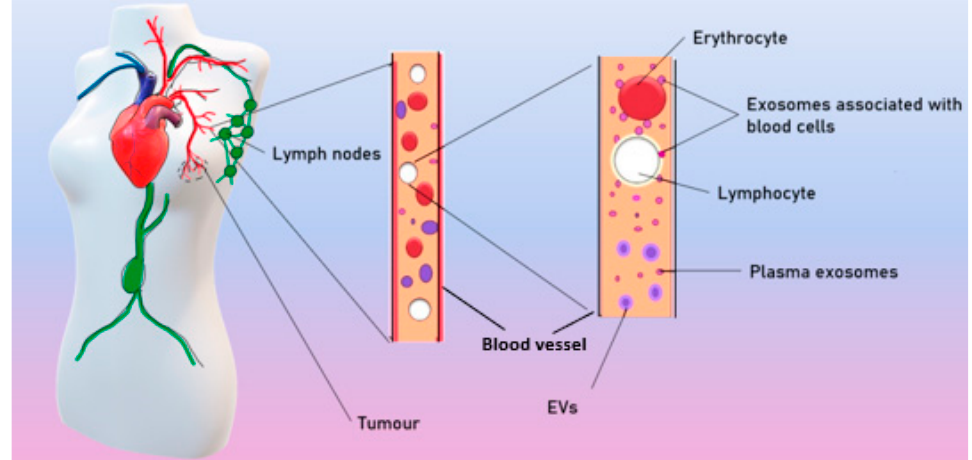
Figure 2. Spreading of tumor exosomes in organism.